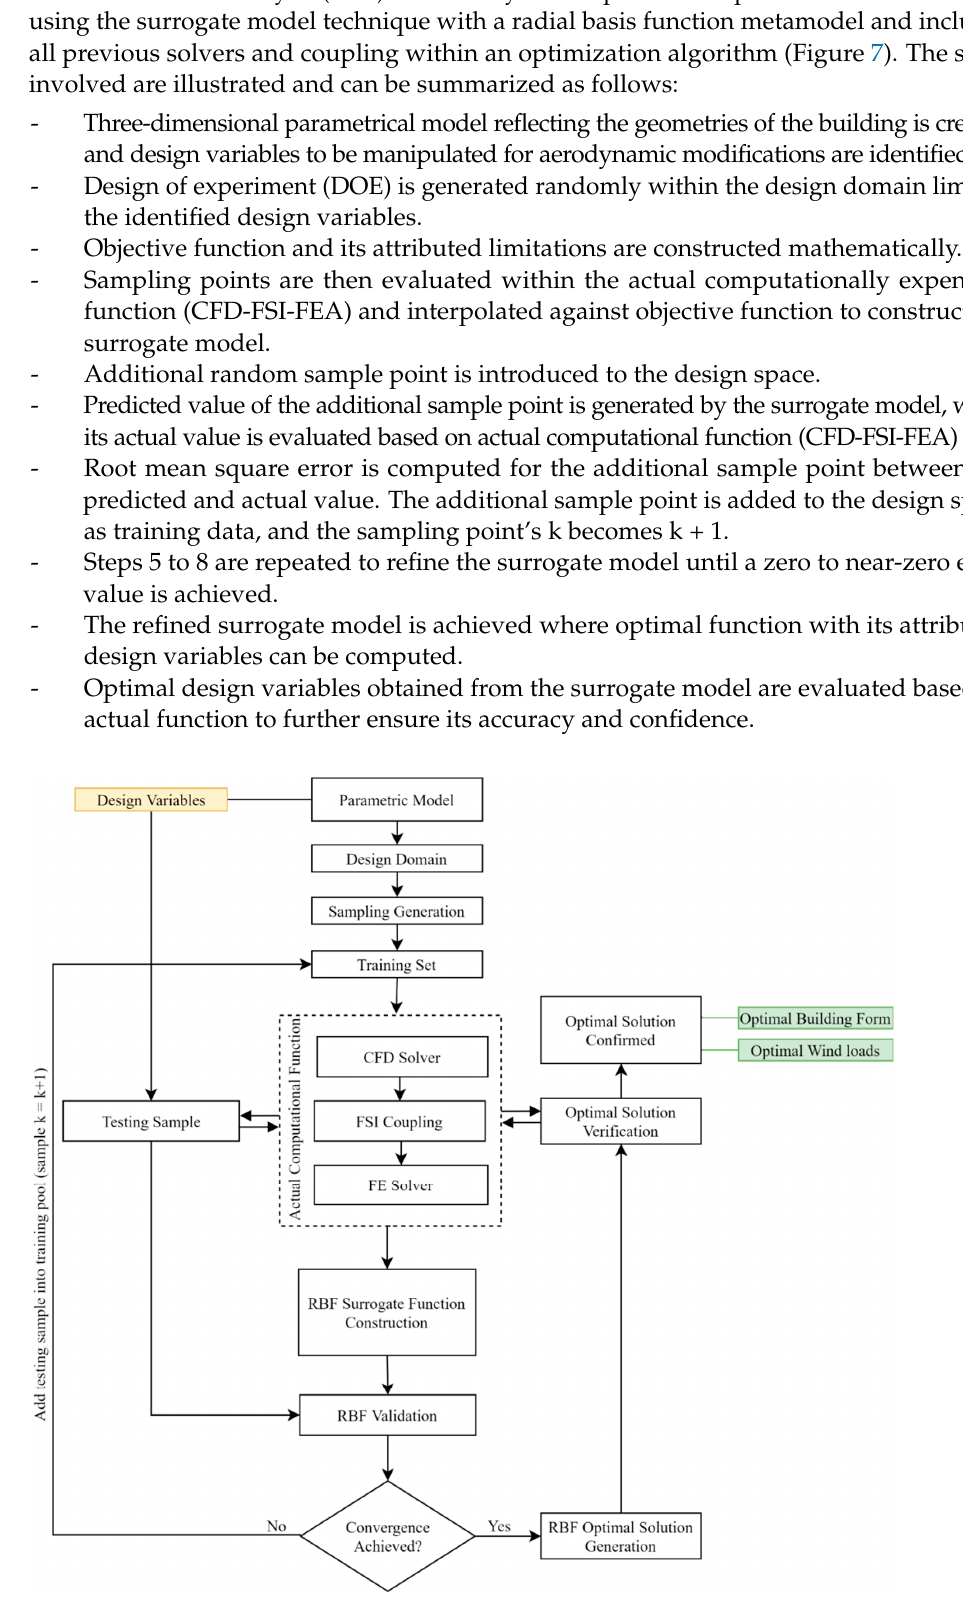
Figure 7. Aerodynamic optimization process.